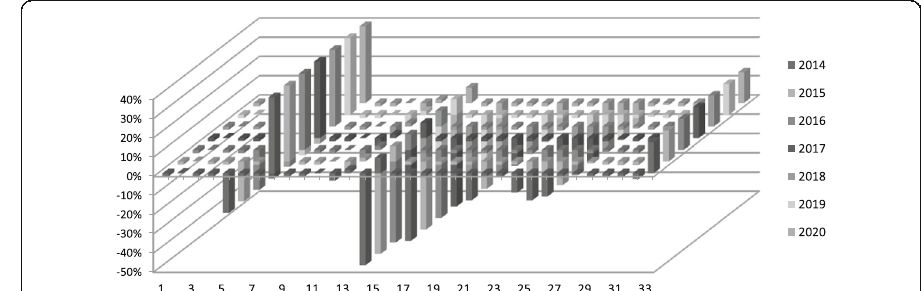
Fig. 3 Percentage change in output of financial commodities from the